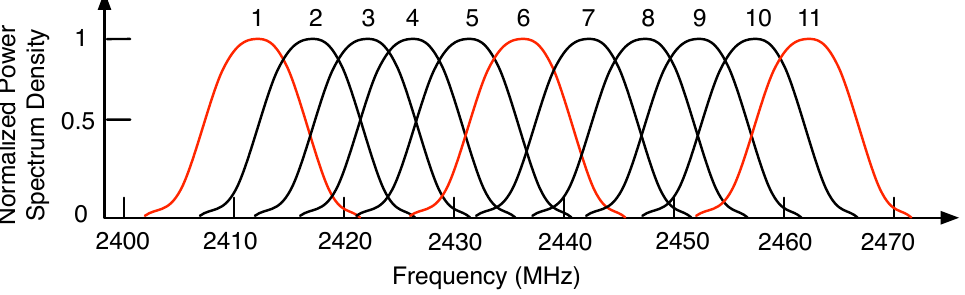
Figure 1. IEEE 802.11 b/g frequency spectrum